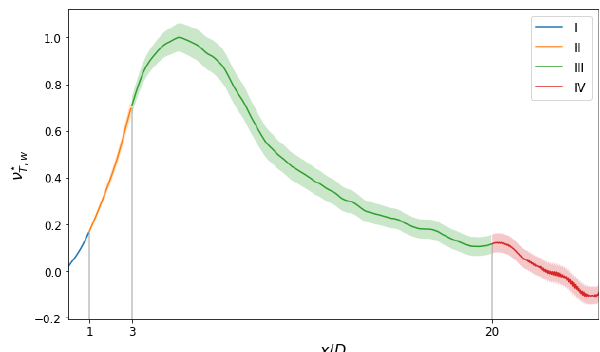
Figure 6. Scaled streamwise wake eddy viscosity for aligned tur- bine cases with fit error and the proposed model Eq. (15). Note that experimental measurements only extend to 7 D downstream so long as wake recovery is exclusively from simulated data. Curves are depicted for SOWFA-6 LES cases as the streamwise resolution is sufficiently